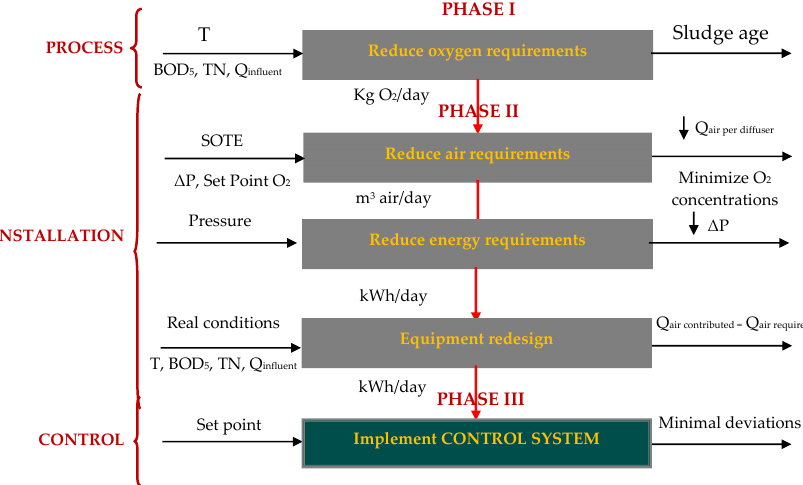
Figure 3. Stages included in an energy optimization of an aeration system.